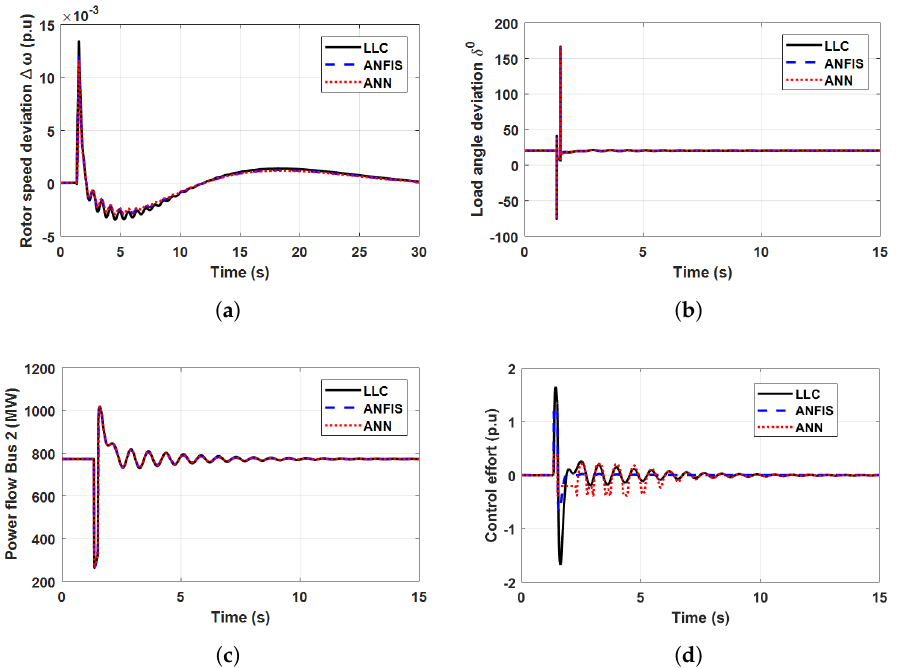
Figure 8. Case 1: Two-area power System with SSSC. ( a ) Rotor speed deviation. ( b ) Load angle deviation. ( c ) Flow of power through the line 2. ( d ) control effort.